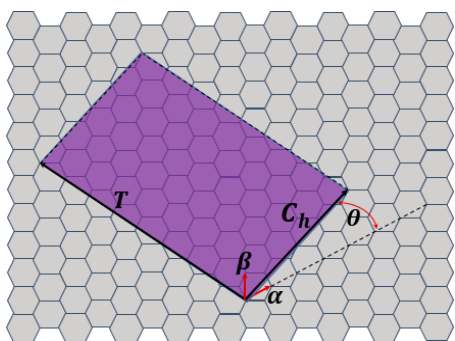
Figure 1. Schematic of an unrolled graphene sheet, determinations of geometrical parameters used to qualify a carbon nanotube, and forming an SWCNT with them [11,16].